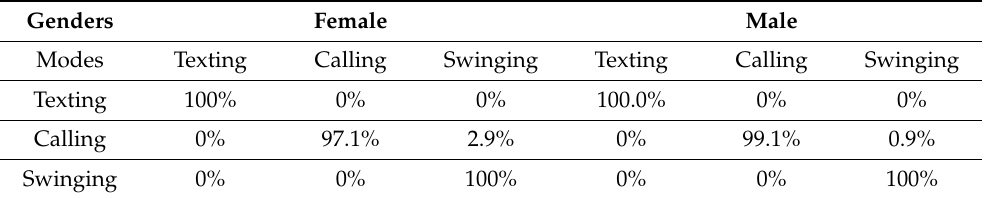
Table 3. Confusion Matrix of the DTree Algorithm.